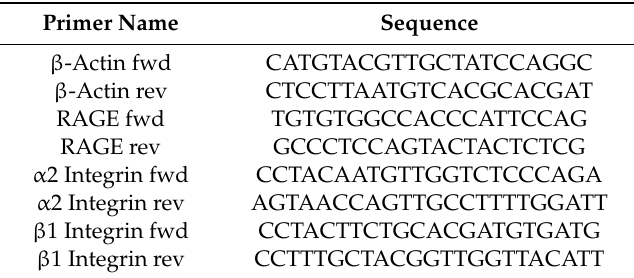
Table 1. Sequence of primers used in this